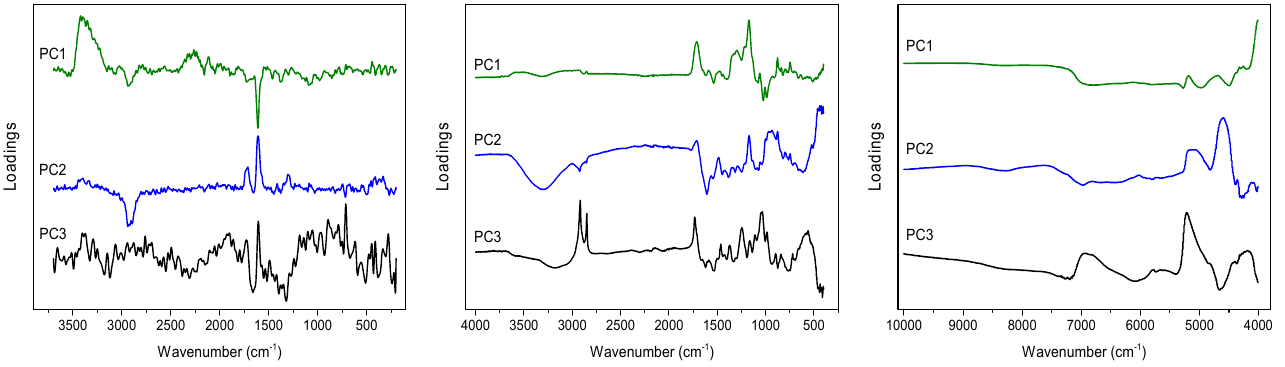
Figure 2. PCA loadings plots obtained on the basis of Raman ( left ), ATR ( middle ) and NIR ( right ) spectra analysis of C. incanus material .